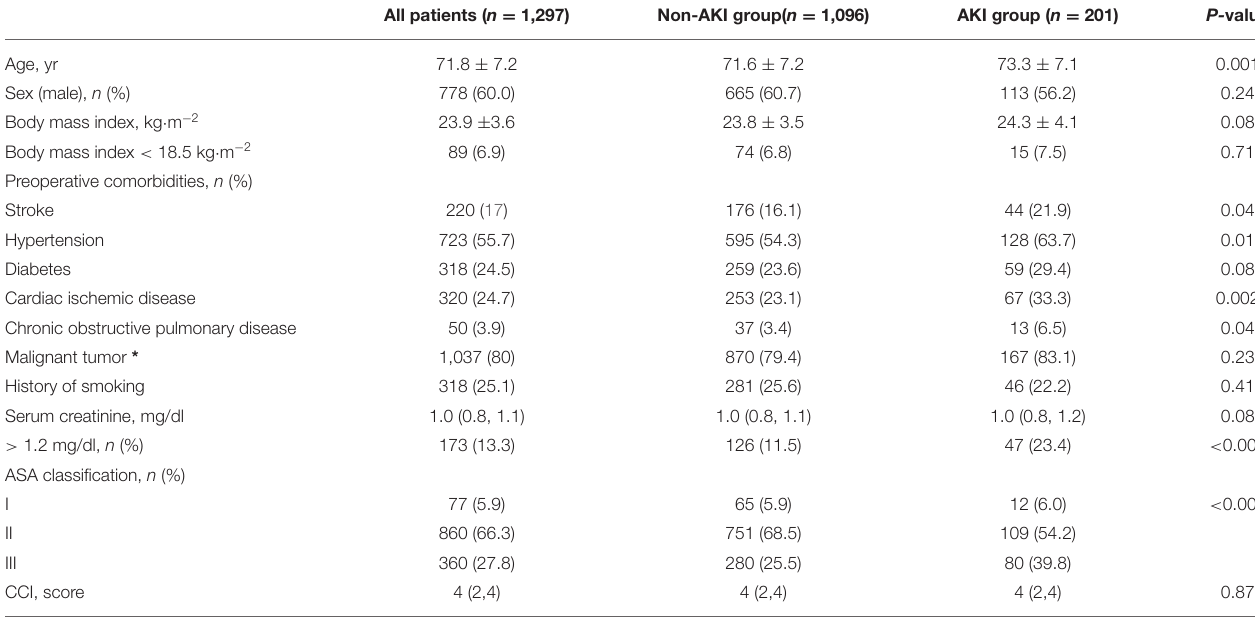
TABLE 1 | Demographic and baseline variables.